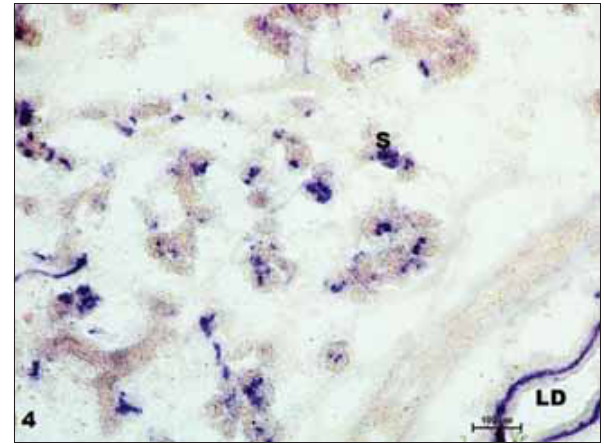
Figure-4: Photomicrograph showing moderate granular alkaline phosphatase activity in serous acini (S) and large duct (D) of submandibular salivary gland of buffalo fetus at 42 cm curved crown-rump length (168 days) (Coupling azo dye method ×